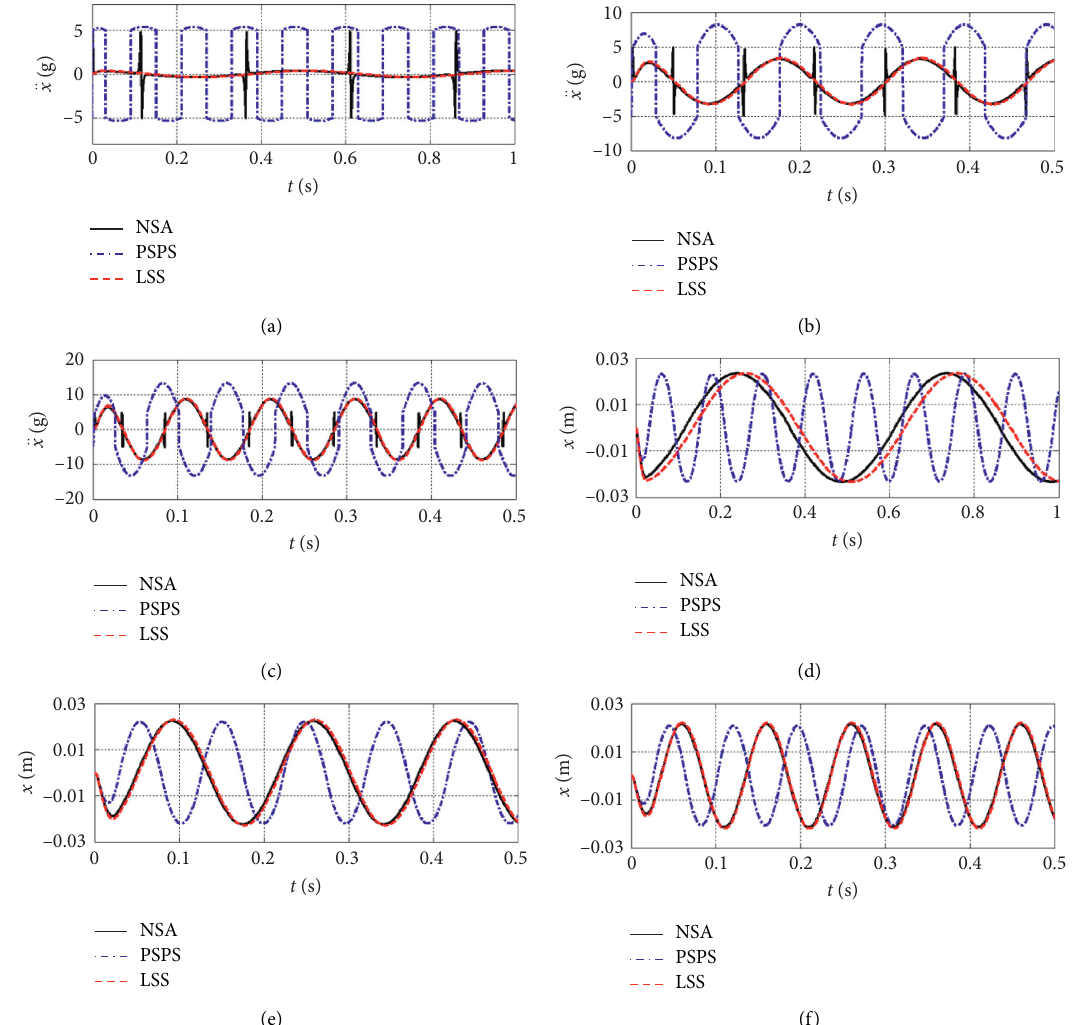
Figure 12: The frequency response of the NSA ( w � 200 π /s, μ � 6 . 7 × 10 − 4 ). (a) Different frequency ratio Ω , ζ � 0, 􏽥 A � 1. (b) Different damping ratio ζ , Ω � 120, 􏽥 A � 1. (c) Different preload amplitude 􏽥 A .